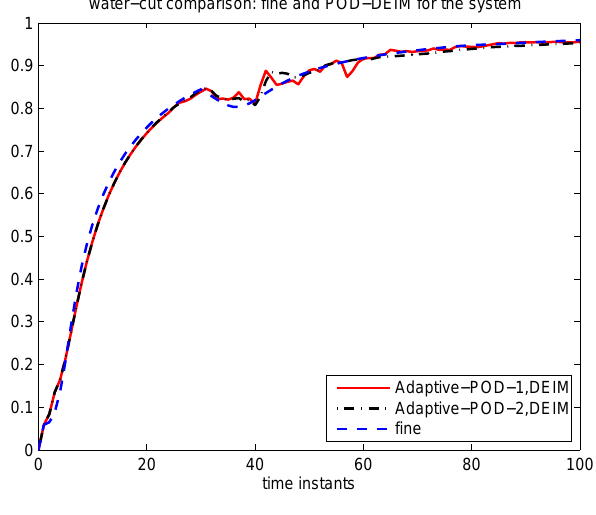
Figure 16. Water-cut of online adaptive POD-DEIM for the coupled